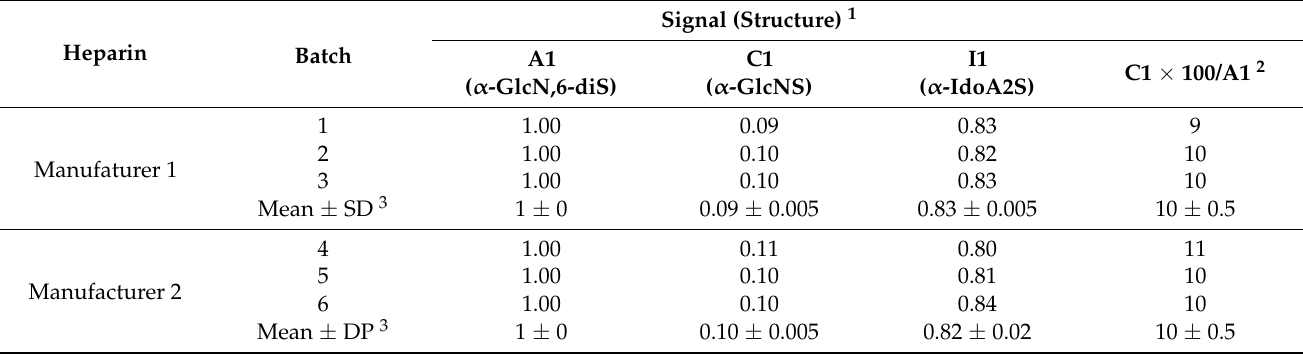
Table 2. Integrals of the anomeric signals of the six batches of heparin from two